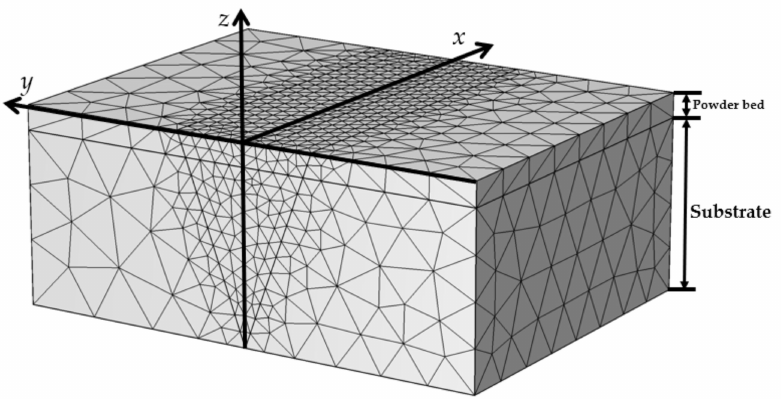
Figure 3. The geometry of the powder bed and substrate, with a finer mesh along the direction of the laser’s